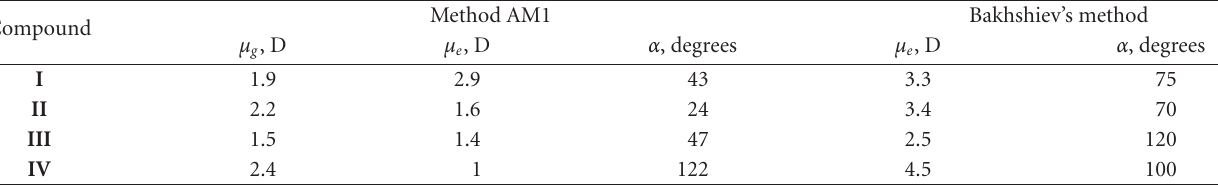
Table 1: Dipole moments of compounds I – IV in the ground ( μ g ), excited ( μ e ) states, and the angle between them ( α ). Method AM1 Compound